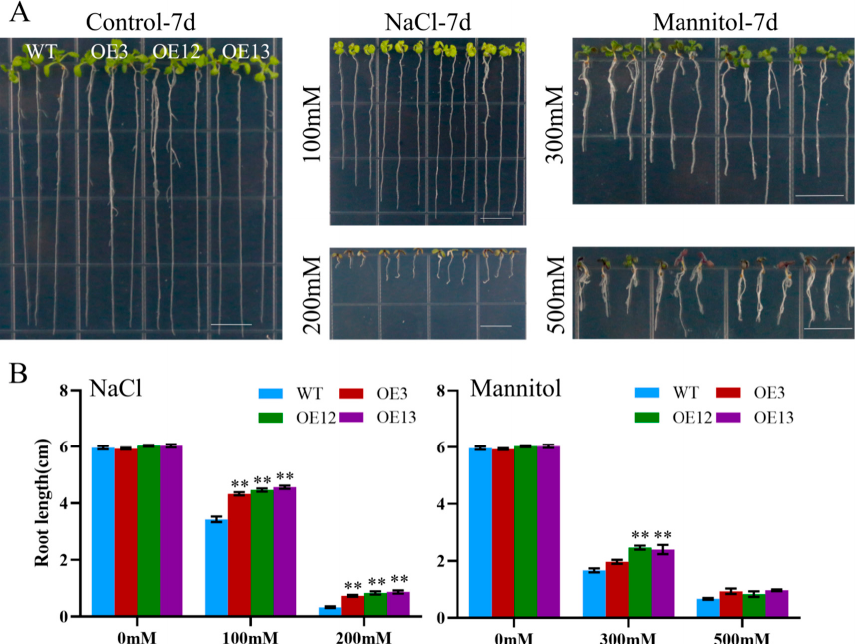
Figure 9. Assays of the length of the primary roots of the WT and MiCOL16B transgenic lines under abiotic stress. ( A ) Seeds of the WT and three transgenic lines grown on half-strength MS media and subjected to various stresses. The bars represent 1.0 cm. ( B ) Lengths of the roots of all the lines under salt and drought treatment. Significant differences among the samples were assessed at the p < 0.01 (**) levels by Student’s t tests.